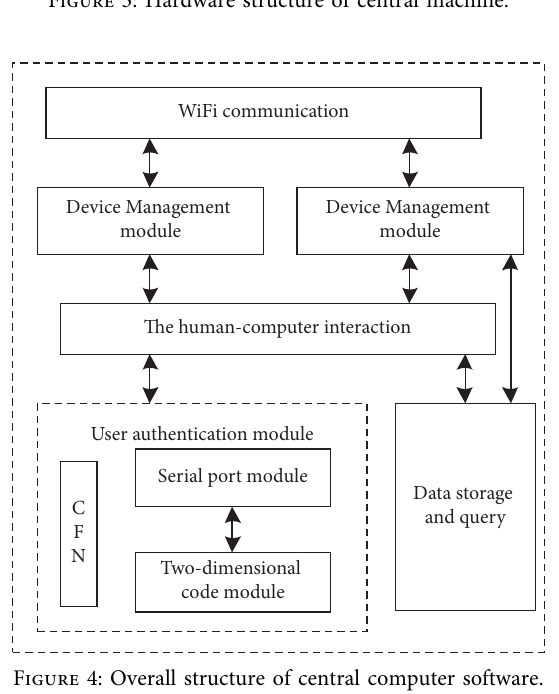
Figure 4: Overall structure of central computer software.